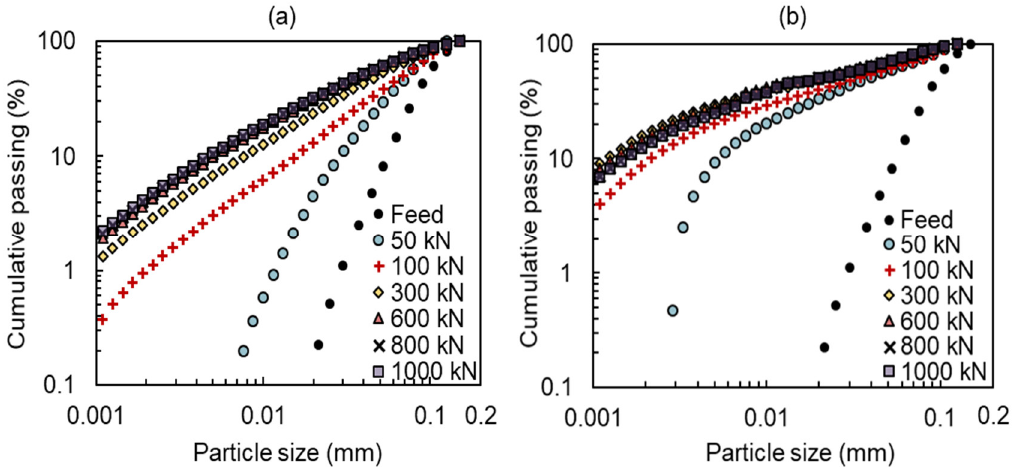
Figure 6. Product size distributions for different maximum compressive forces for the ( a ) Brucutu and ( b ) Carajás samples contained in the size range of 150–125 µm in piston-and-die tests.